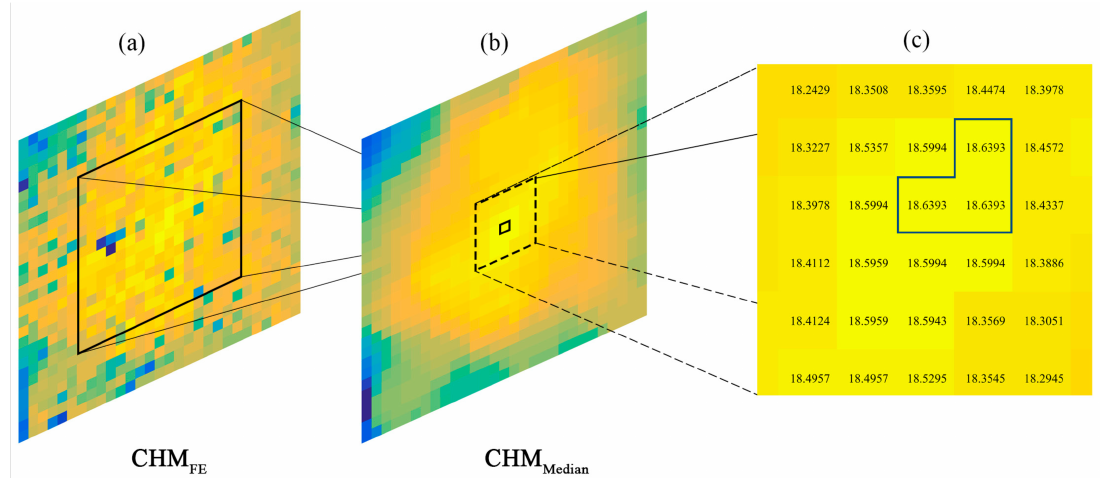
Figure 9. An example of median filtering: ( a , b ) the filtering process with a 17 × 17 window size; ( c ) the obtained continuous local maxima are shown in the blue